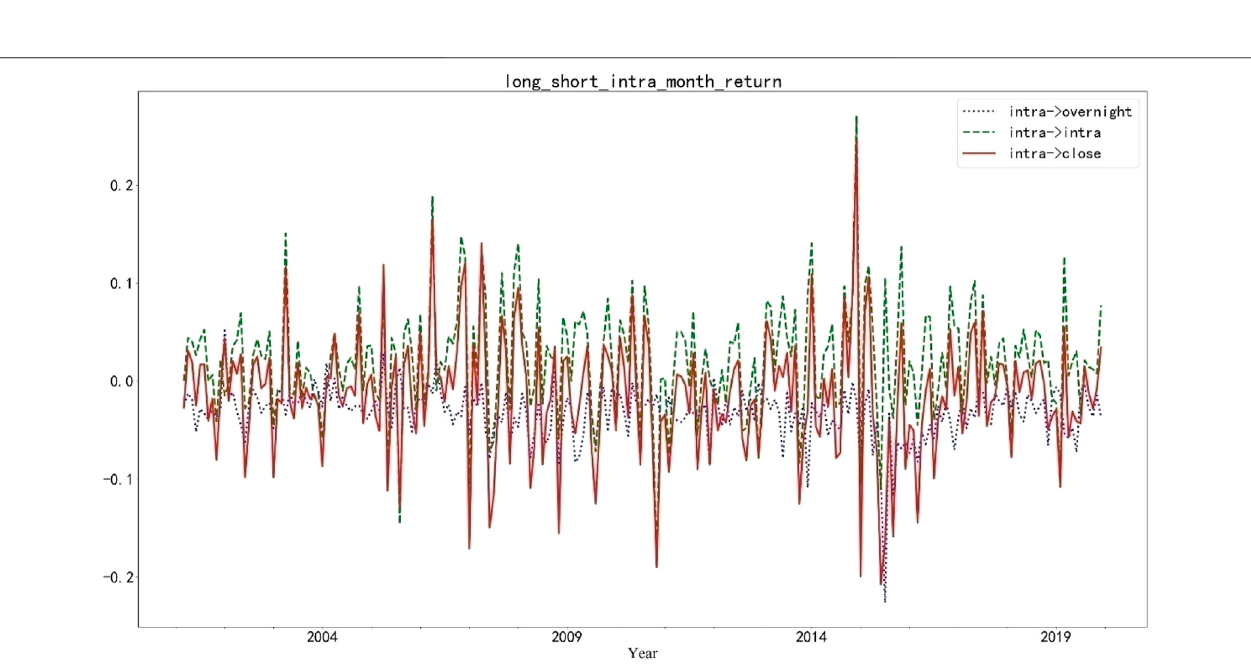
Frontiers in Energy Research |